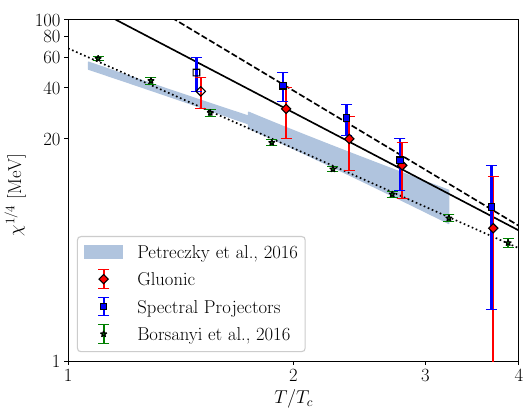
Figure 3. Behavior of χ 1 / 4 as a function of T / T c in log-log scale. Gluonic points are slightly shifted to improve readability. Starred points represent results taken from Ref. [3] (with isospin-breaking fac- tor removed), while the shaded area represents the gluonic determinations reported in Ref. [4], mass- rescaled according to χ 1 / 4 ∼ m π